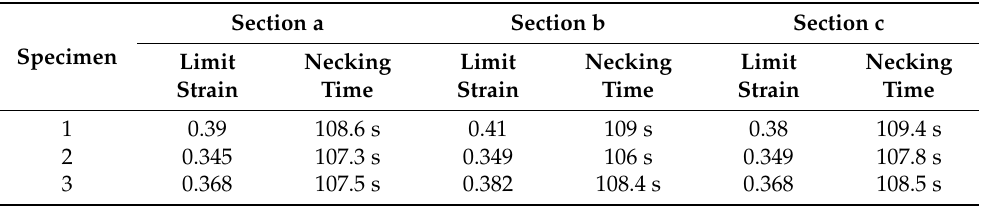
Table 3. Summary of the limit major strain of low-carbon steel sheet with 40 mm width specimen of three independent tests.